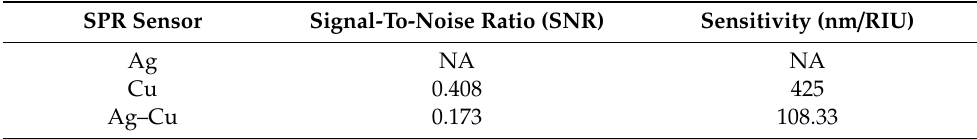
Table 5. Comparison of the sensitivity, SNR, and SPR sensor for all metallic layers at 100%.